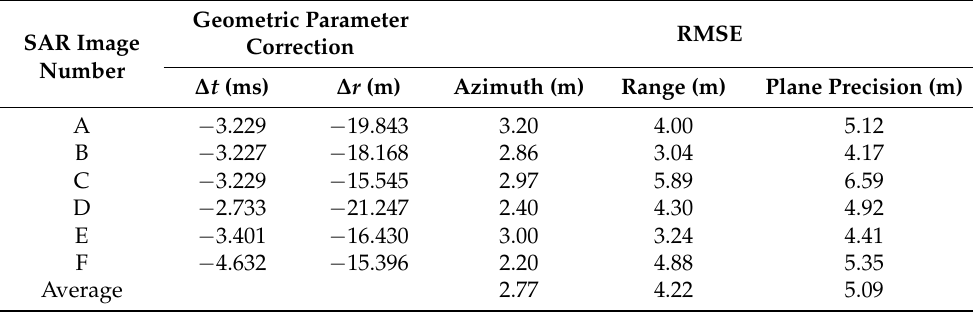
Table 4. Plane precision results of the test images after the geometric calibration process. SAR Image